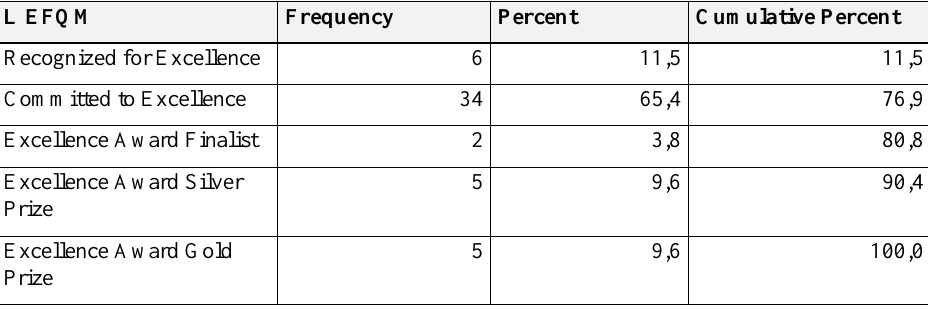
Table 4 – Case Processing